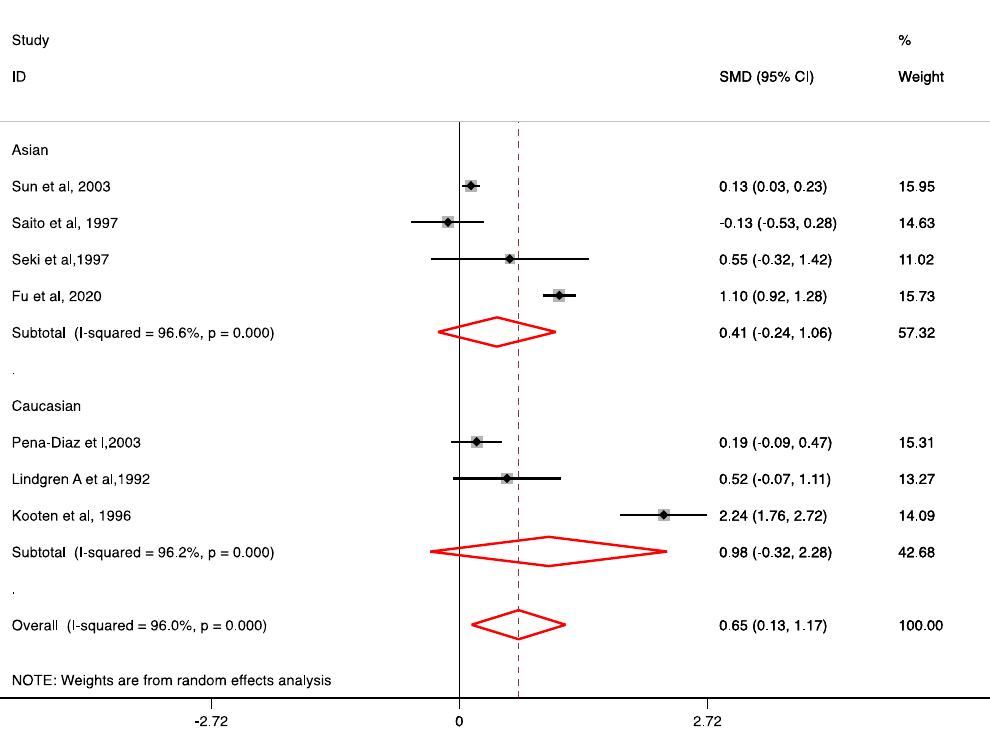
Figure 4. Forest plot for the association of Lp (a) level with the risk of Intracerebral hemorrhage (ICH) vs. control based on